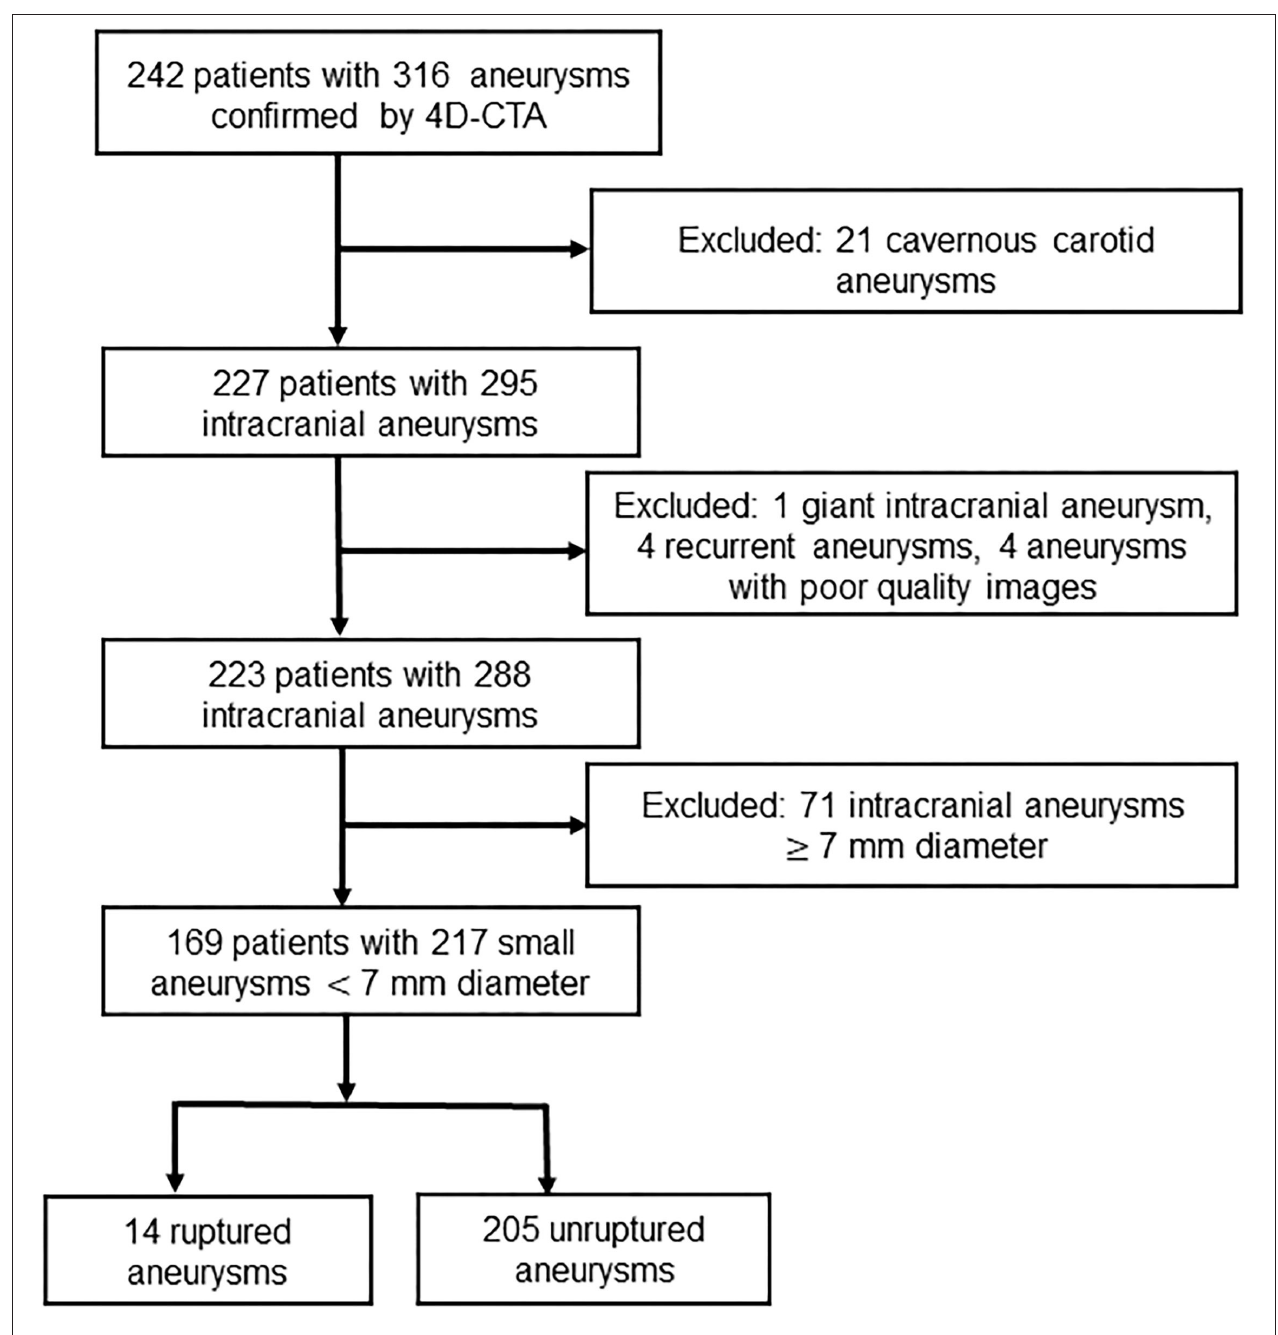
FIGURE 3 | Study flow